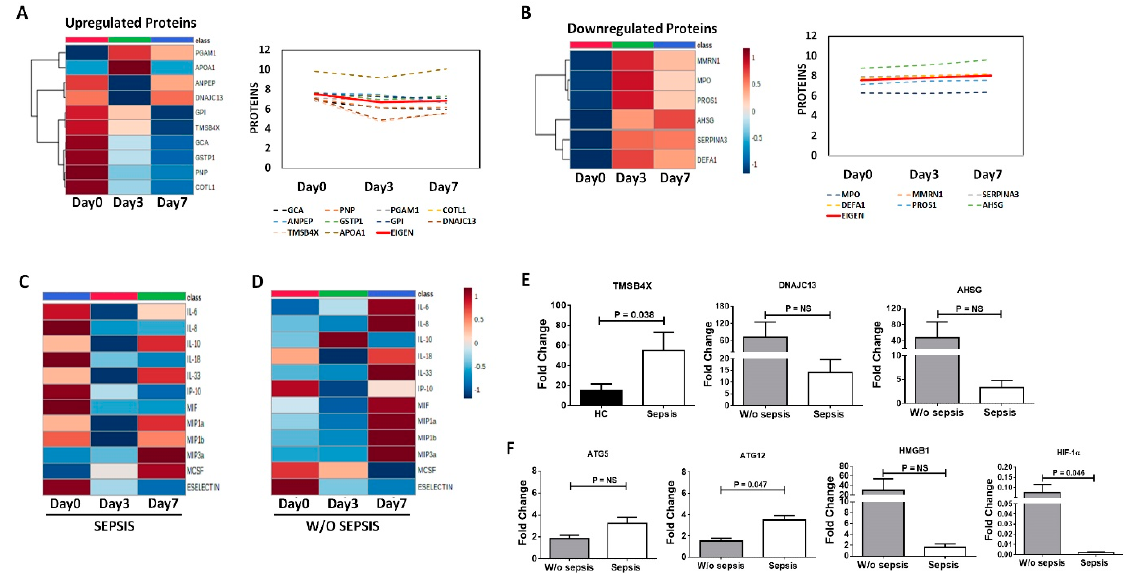
Figure 6. Proteins and cytokines at different time points. Heatmap and Line diagram showing the expression of ( A ) Upregulated and ( B ) downregulated proteins in sepsis patients compared at Day 0, Day 3 and Day 7. The line diagram shows the log values of all the proteins (dotted line) and Eigen value of all the proteins (solid line). An eigen values are unit-less and are derived via PCA. Expression of cytokines, chemokines, and growth factors in ( C ) sepsis and ( D ) w / o sepsis at different time points i.e., Day 0, Day 3 and Day 7. Column bar graphs show fold change of ( E ) TMSB4X, DNAJC13, and AHSG, and ( F ) ATG5, ATG12, HMGB1 and HIF-1 α using QRT-PCR.